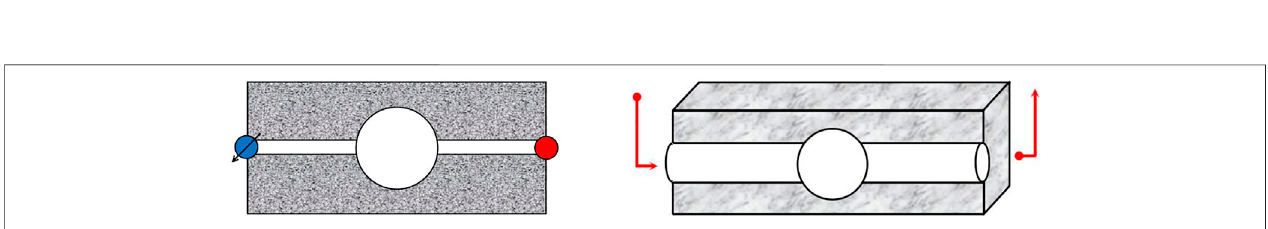
FIGURE 9 | Physical model of pipe series cavity in one injection-production